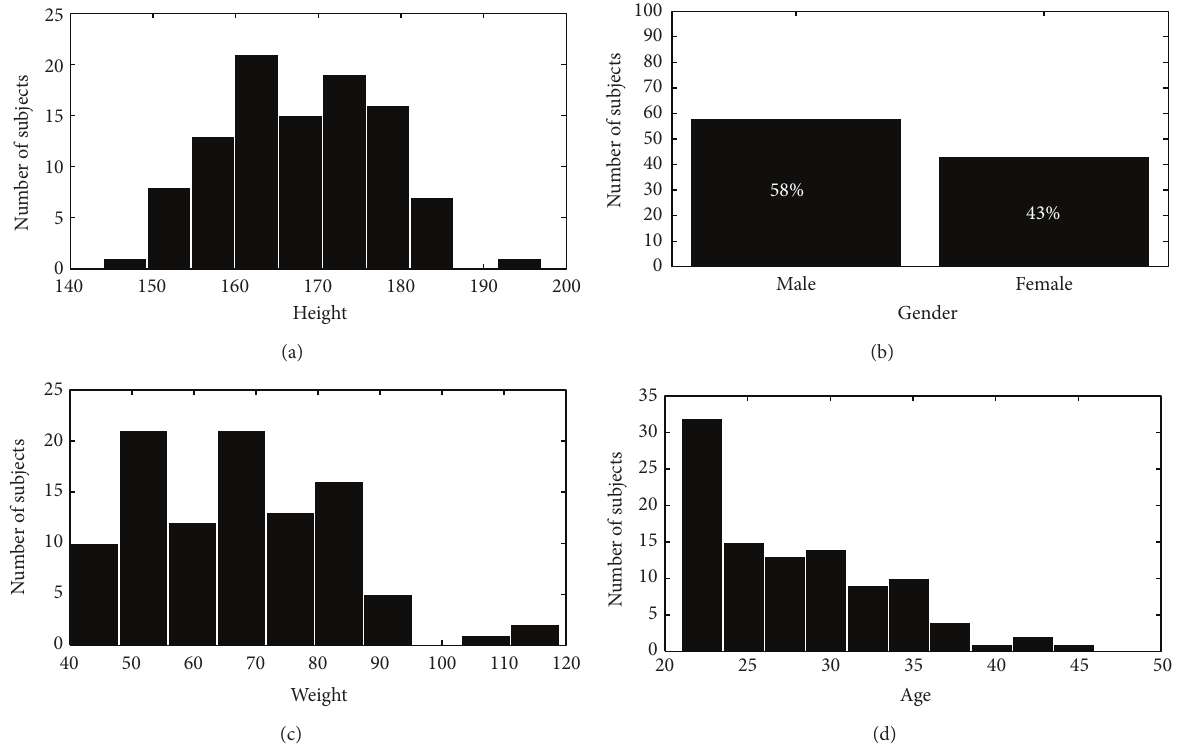
Figure 2: Plot of metadata of subjects according to height, gender, weight, and age distribution.